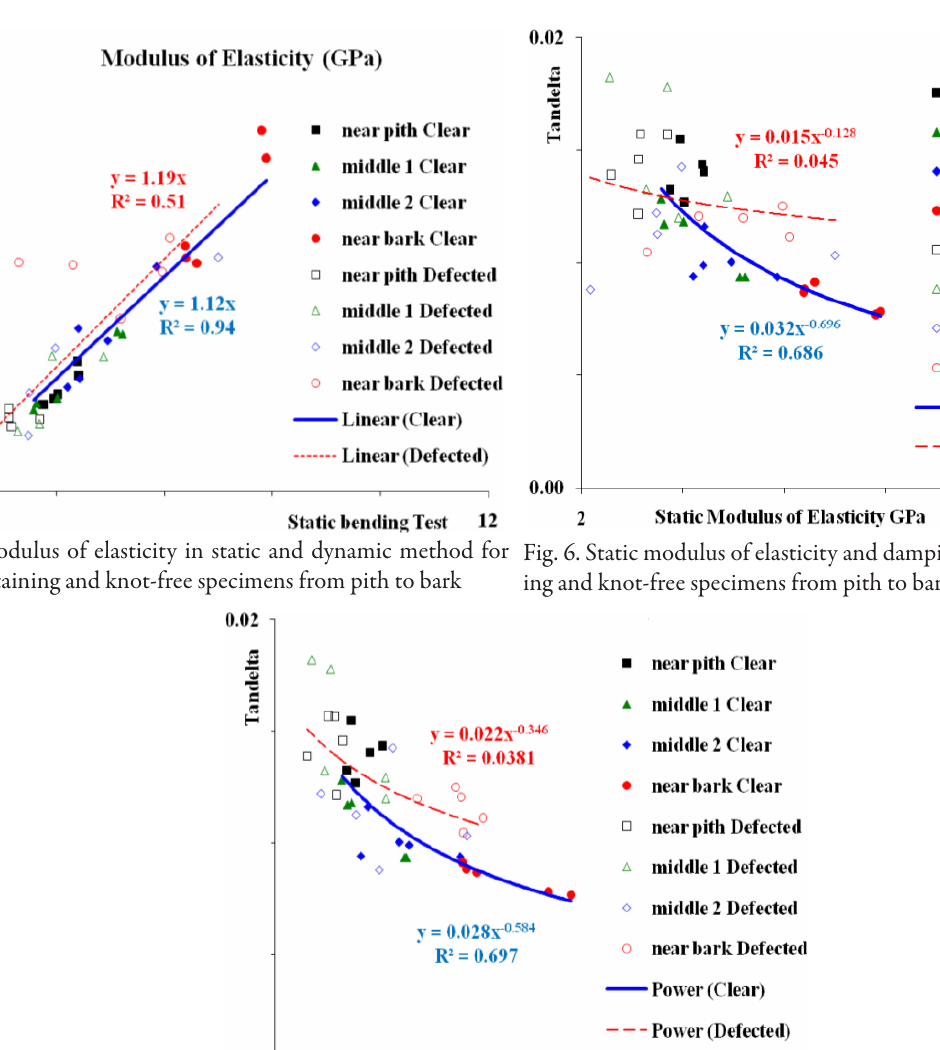
Fig. 7. Dynamic modulus of elasticity and damping in knot-con- taining and knot-free specimens from pith to